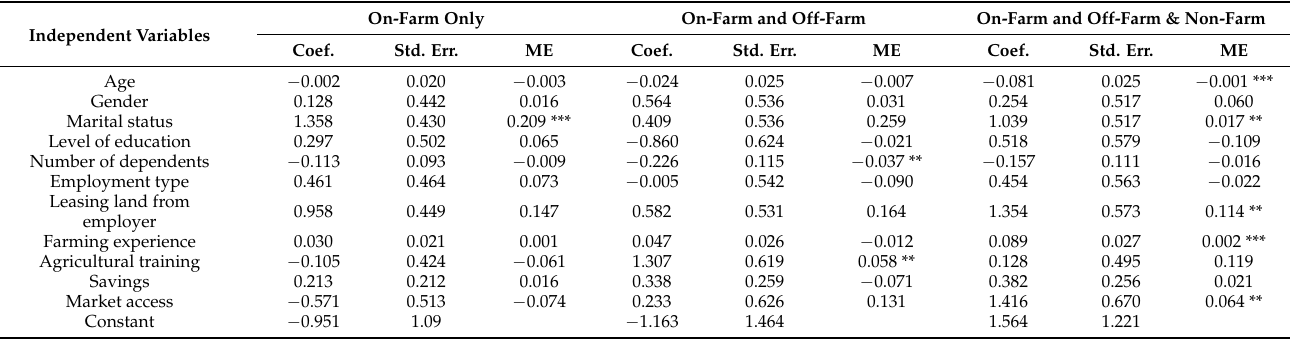
Table 4. Multinomial logistic results of the factors that influence livelihood-diversification strategies among irrigation